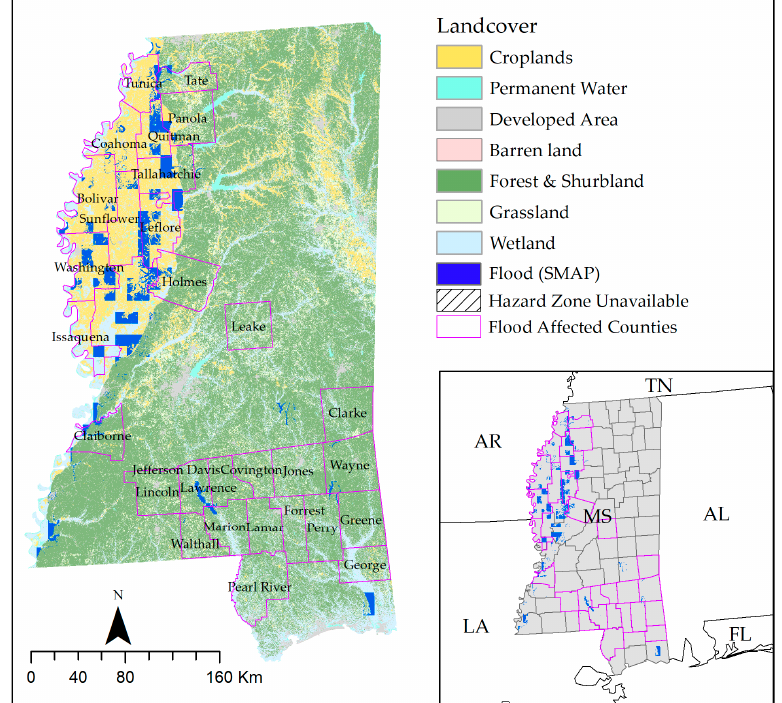
Figure 10. Inundation map extracted from SMAP of the Mississippi Flood (March 2016) superimposed over CDL.